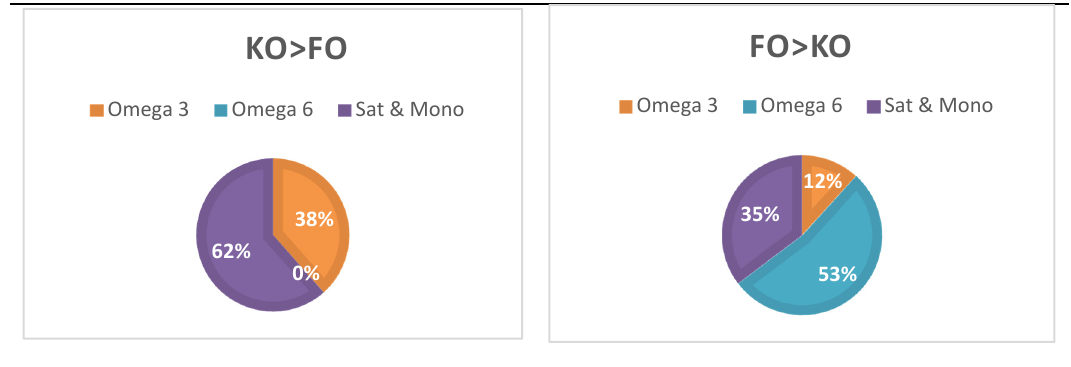
Figure 6. Relative proportions of omega-3 and omega-6 PUFA, and saturated and monounsaturated fatty acids based on relAUC where KO treatment was significantly greater than FO and vice versa. Data derived from Figure 5.